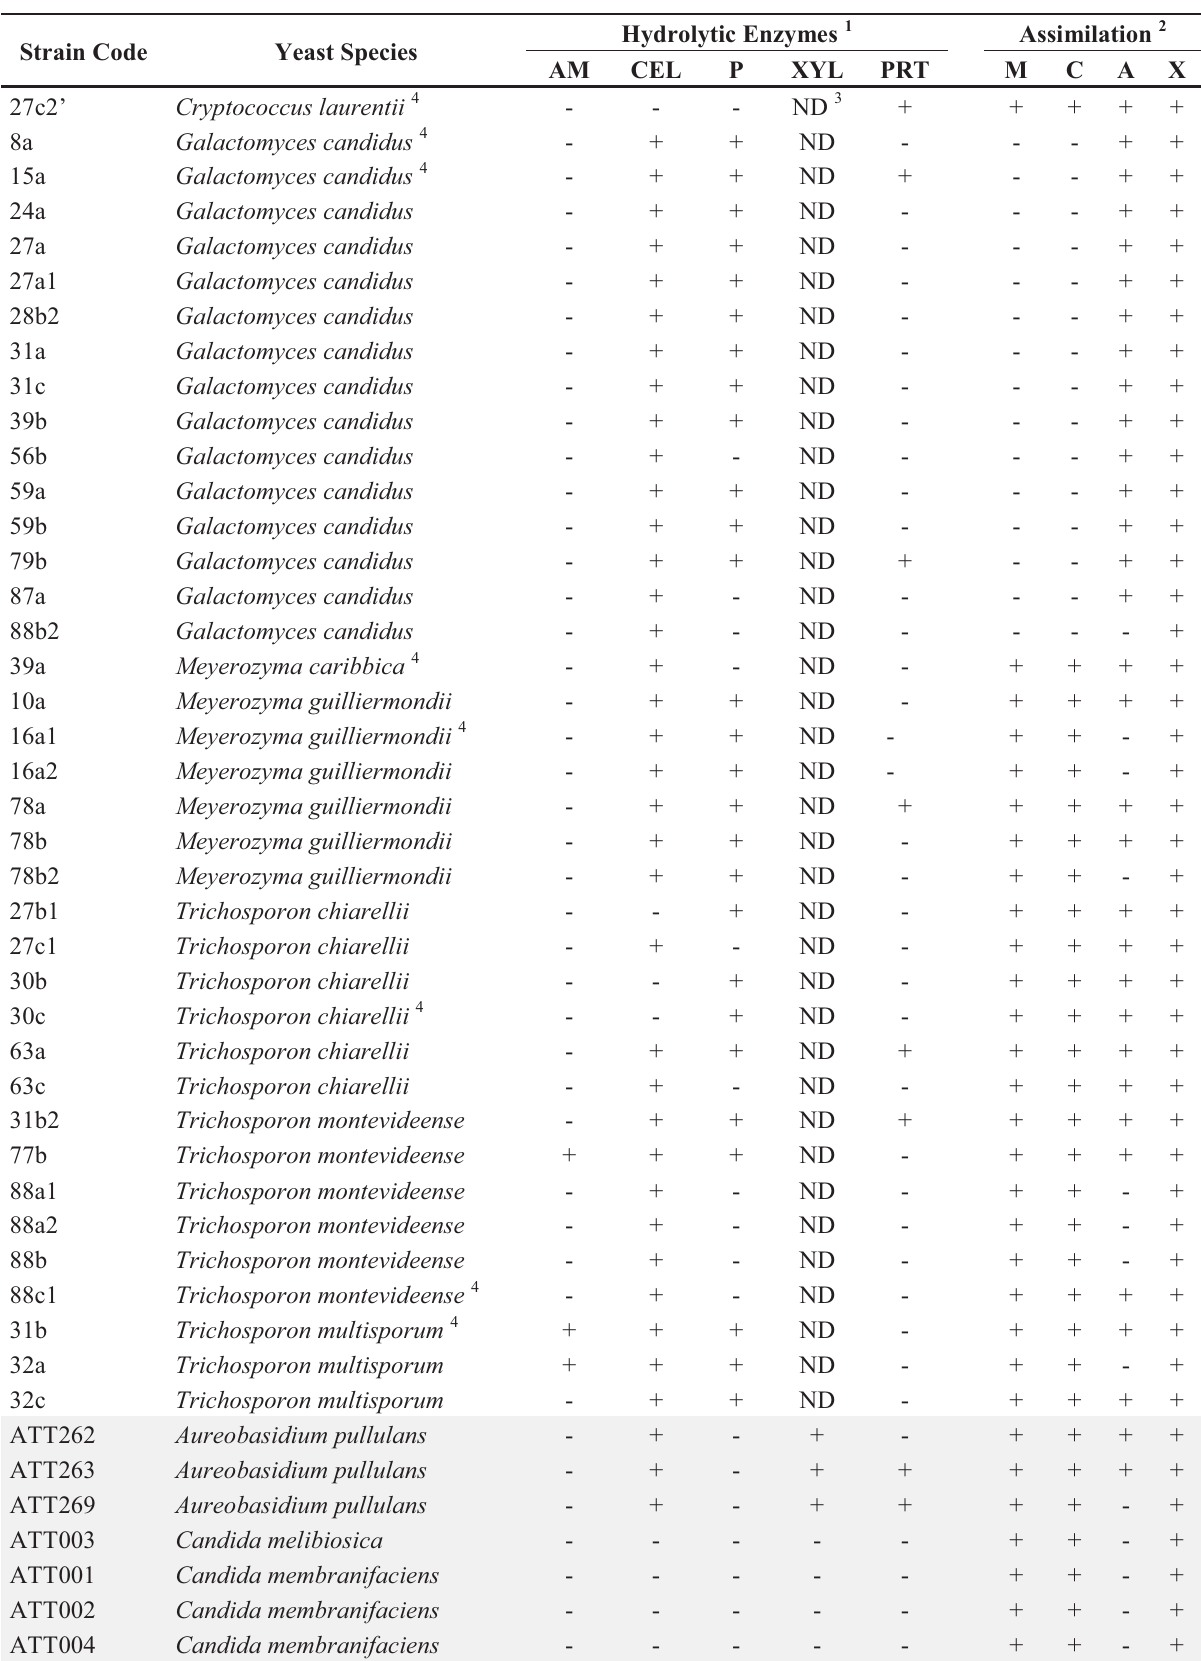
Table S2. Enzymatic activity and assimilation of compounds by yeast and yeast-like fungi examined in this